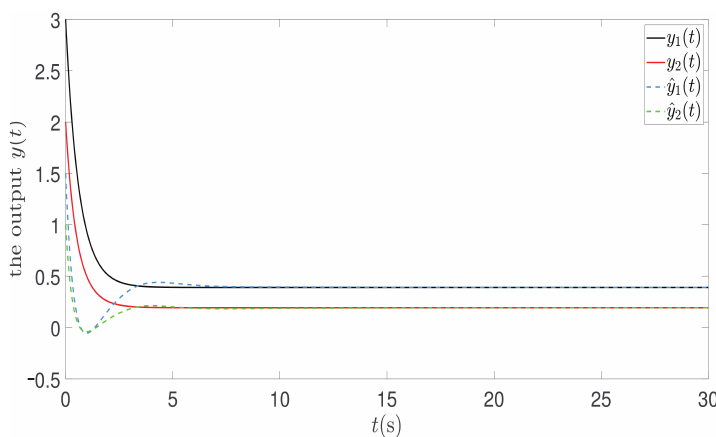
Figure 17. The output and estimated output curves.